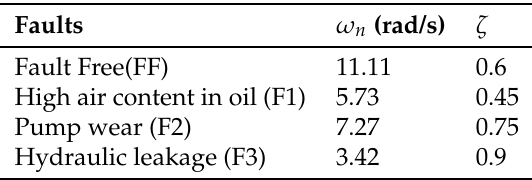
Table 3. Change in dynamics pitch actuator